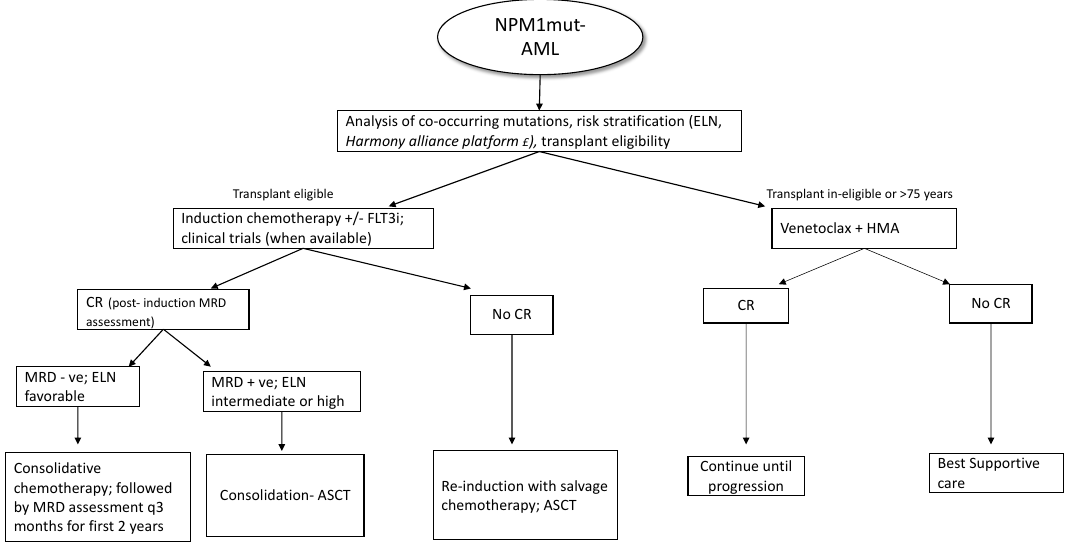
Figure 2. Overview of treatment in NPM1 mut -AML; (FLT3i- FLT3 inhibitor; CR- complete response; ASCT-allogenic stem cell transplant; HMA- hypomethylating agents, £- pending clinical validation) .